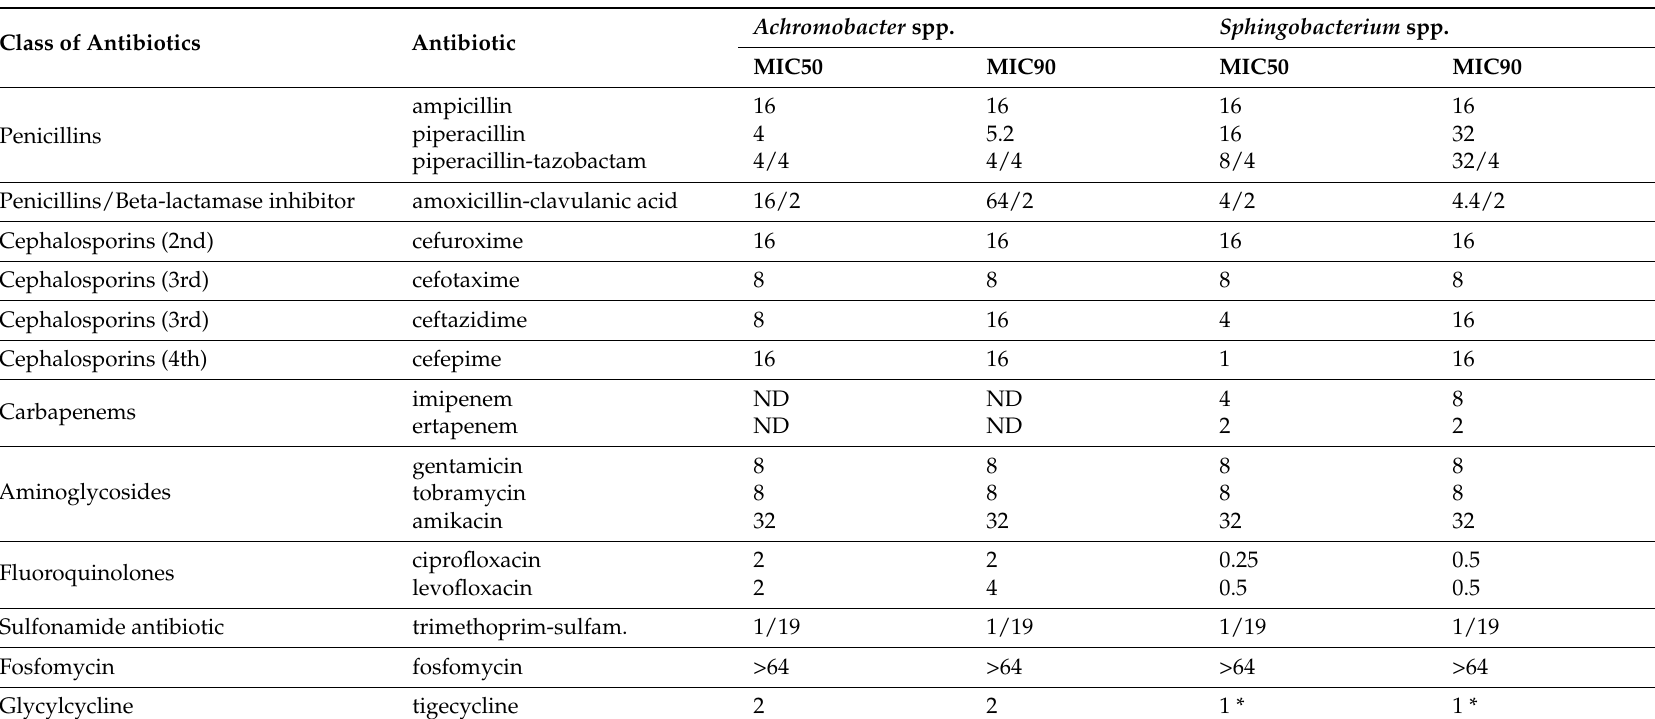
Table 8. MIC50 and MIC90 values of Achromobacter spp. and Sphingobacterium spp. isolates from water and surface areas. Class of